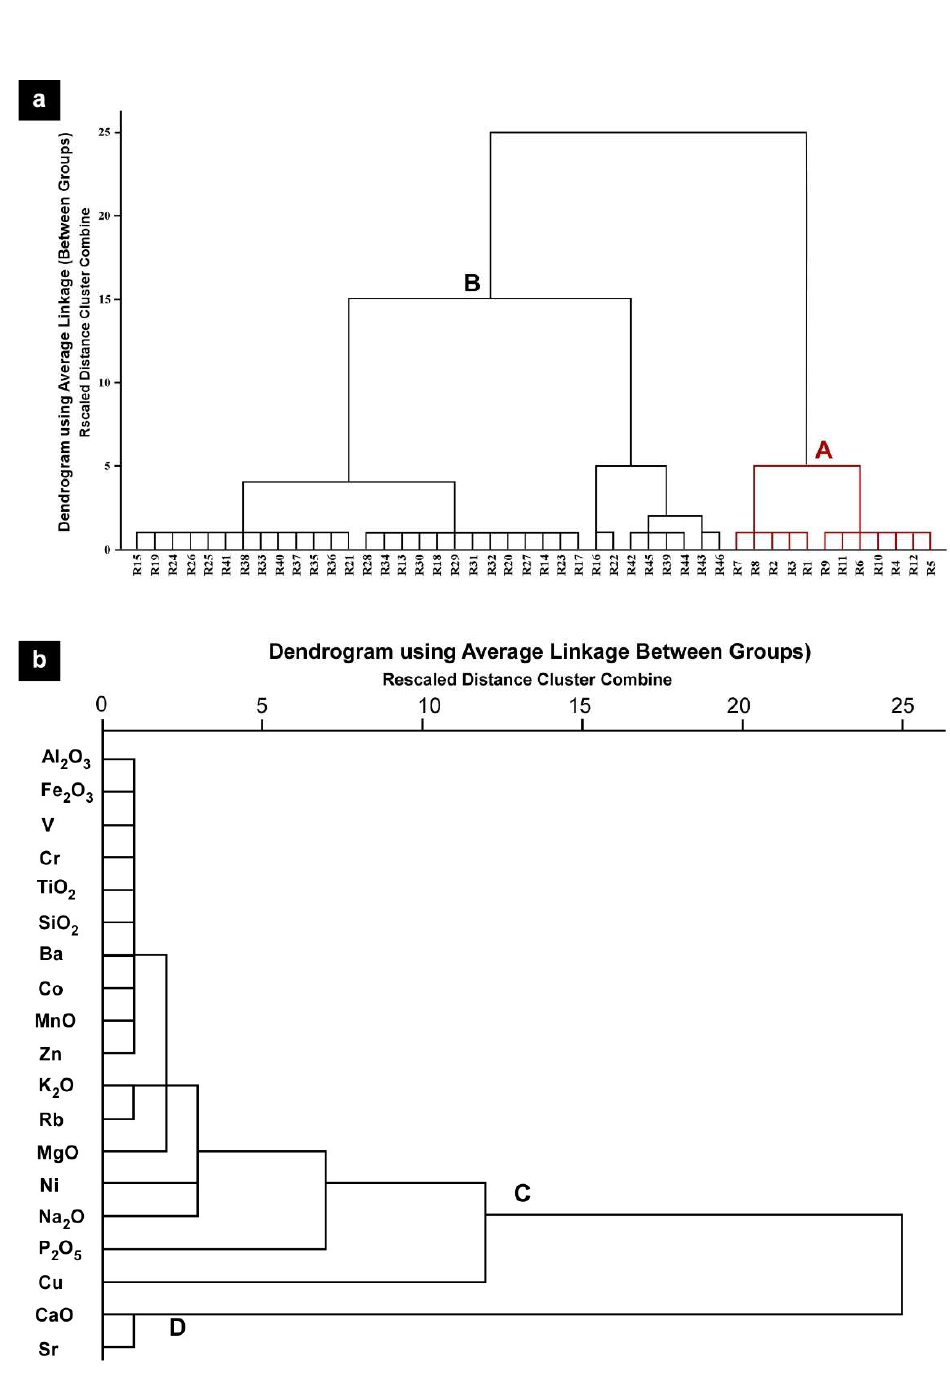
Figure 5. Dendrogram showing the clustering of samples ( a ) into two groups; A and B, representing the southern and northern sectors of the lagoon, respectively. ( b ) Clustering of elements into lithogenous-related (C) and carbonate-related elements (D).